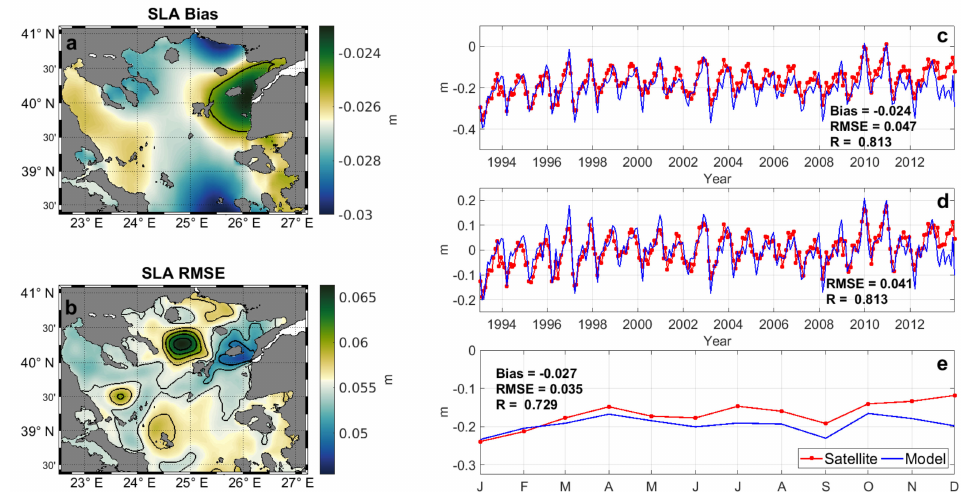
Figure 6. Sea Level Anomaly-based validation of the model: Maps of the Bias and RMSE error of the model are presented in panels ( a , b ), respectively. Time series of the geographical mean SLA of the model (blue) and the satellite observations (red) are presented in ( c ). The temporal SLA anomaly computed over the domain is presented in ( d ), and the modelled and observed seasonal SLA cycle in ( e ).